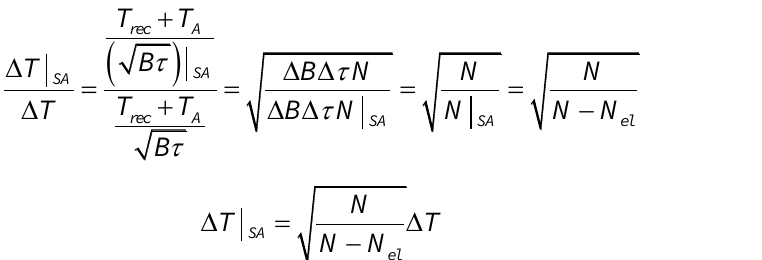
Table 1. Maximum retrieved T error for the best threshold P A Smoothing Algorithm filtering, including the case of not applying the algorithm. Maximum retrieved T error in absence of RFI for the most suitable threshold is also shown. A Filter